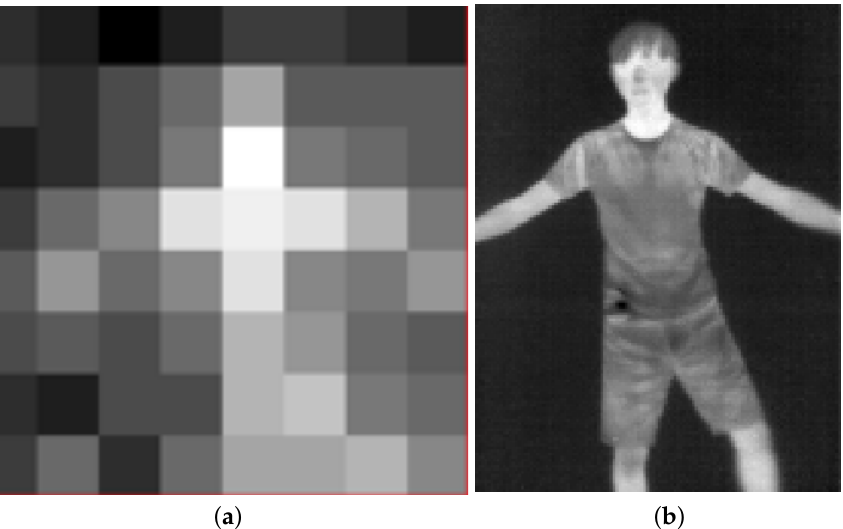
Figure 3. Examples of Thermal Heat-Map Images: ( a ) Low-Resolution Thermal Image; ( b ) High- Resolution Thermal